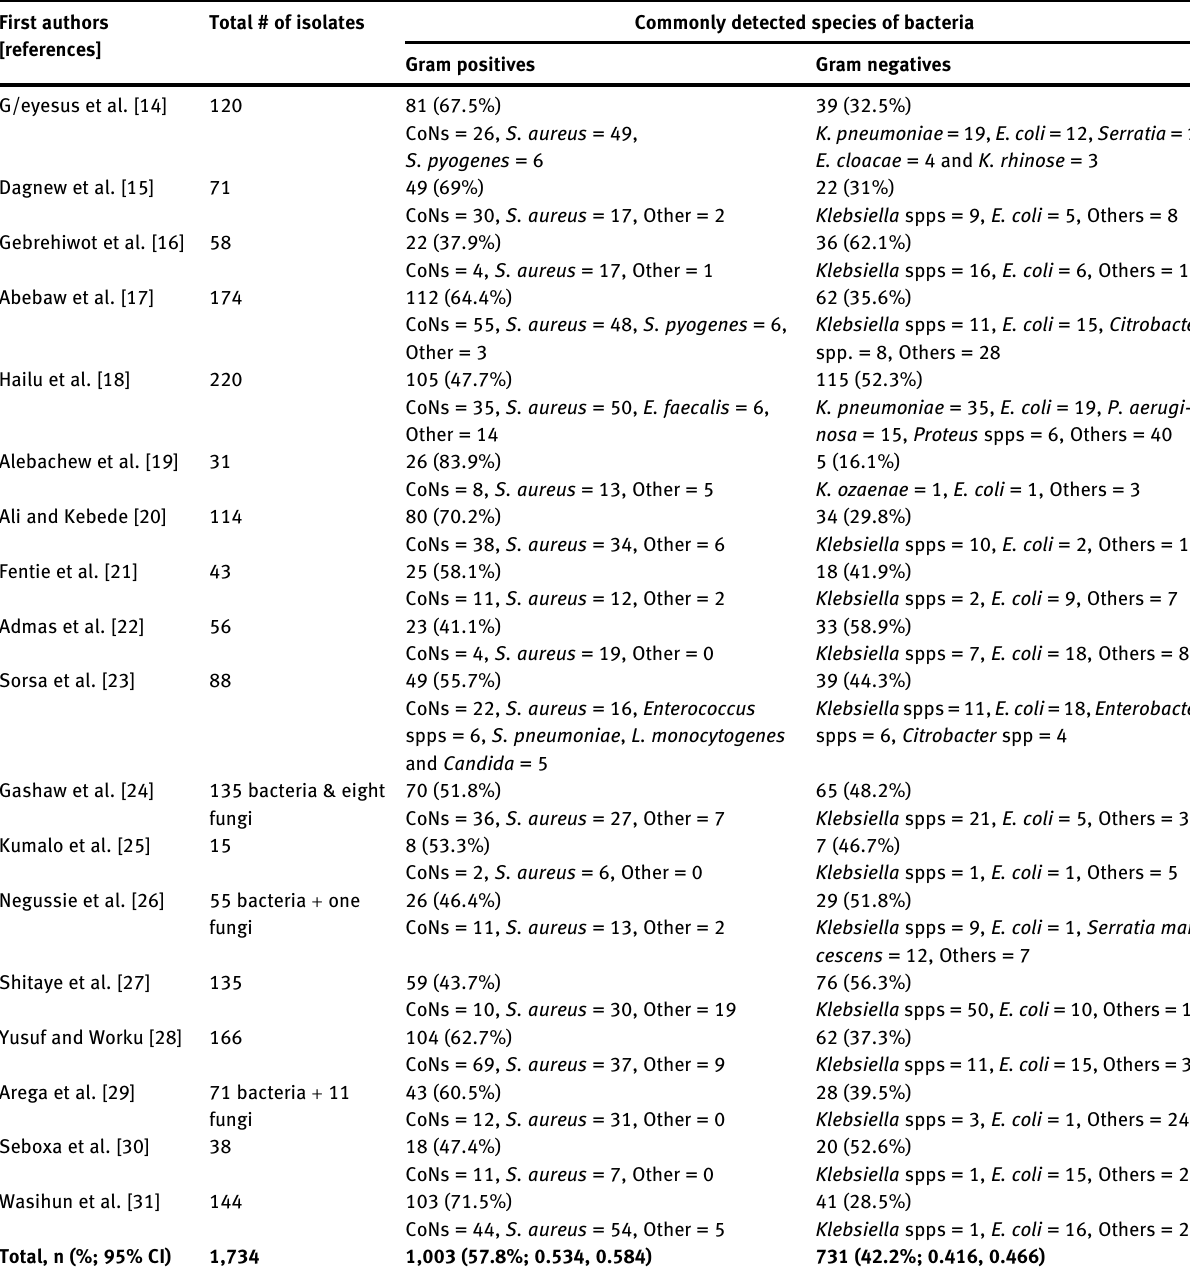
Table  : Summary of studies included regarding the most common isolated bacterial species causing sepsis in